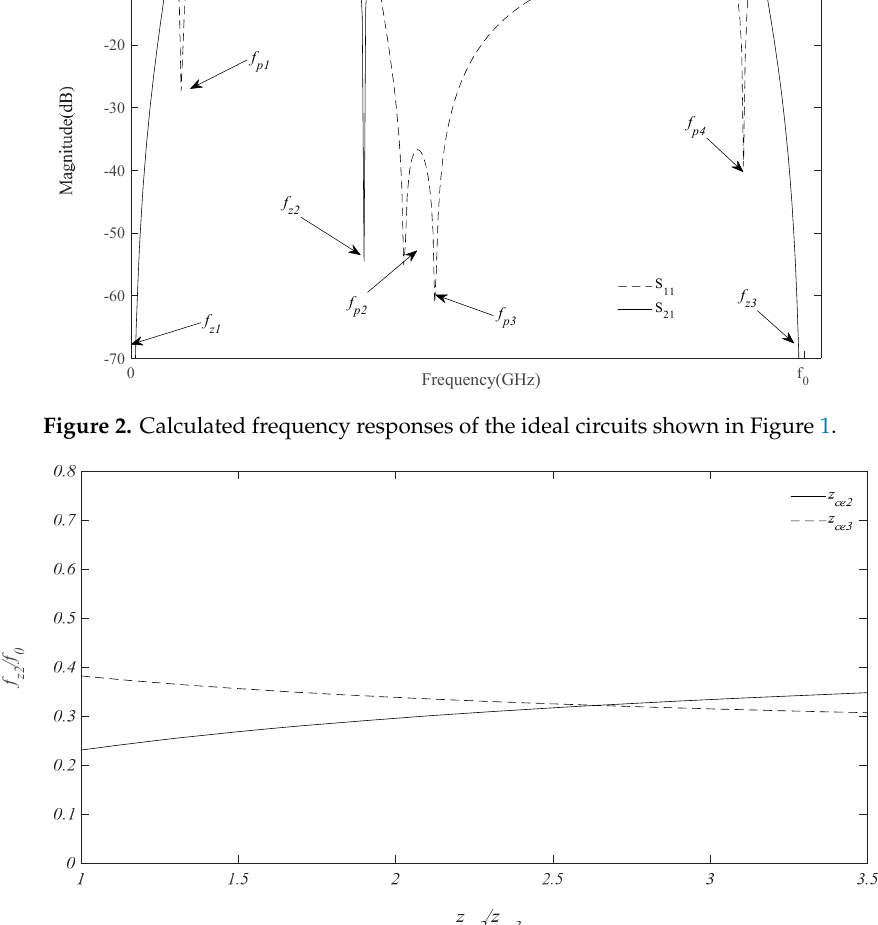
Figure 2. Calculated frequency responses of the ideal circuits shown in Figure 1.